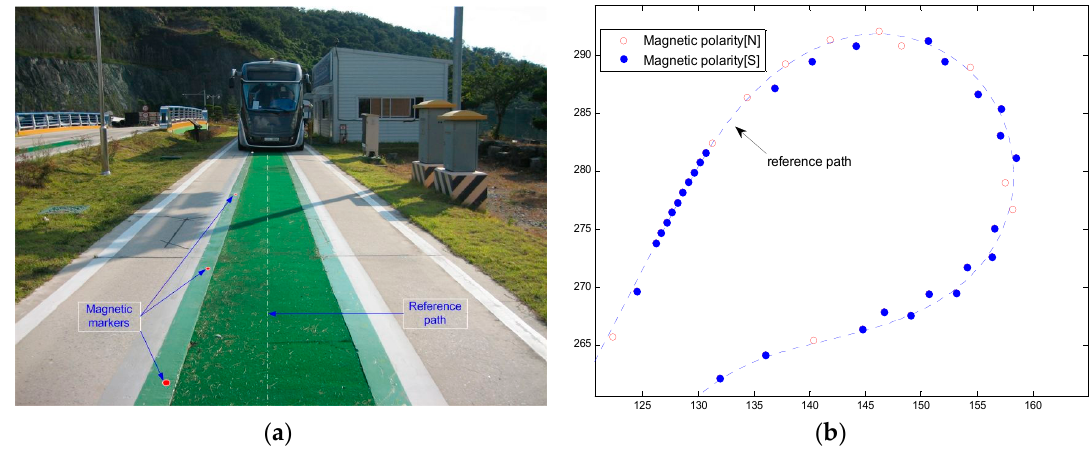
Figure 3. Marker installation on the path. ( a ) Artificial lawn on the path; ( b ) Magnetic markers in the curved section. Table 1. Magnetic marker database [10].